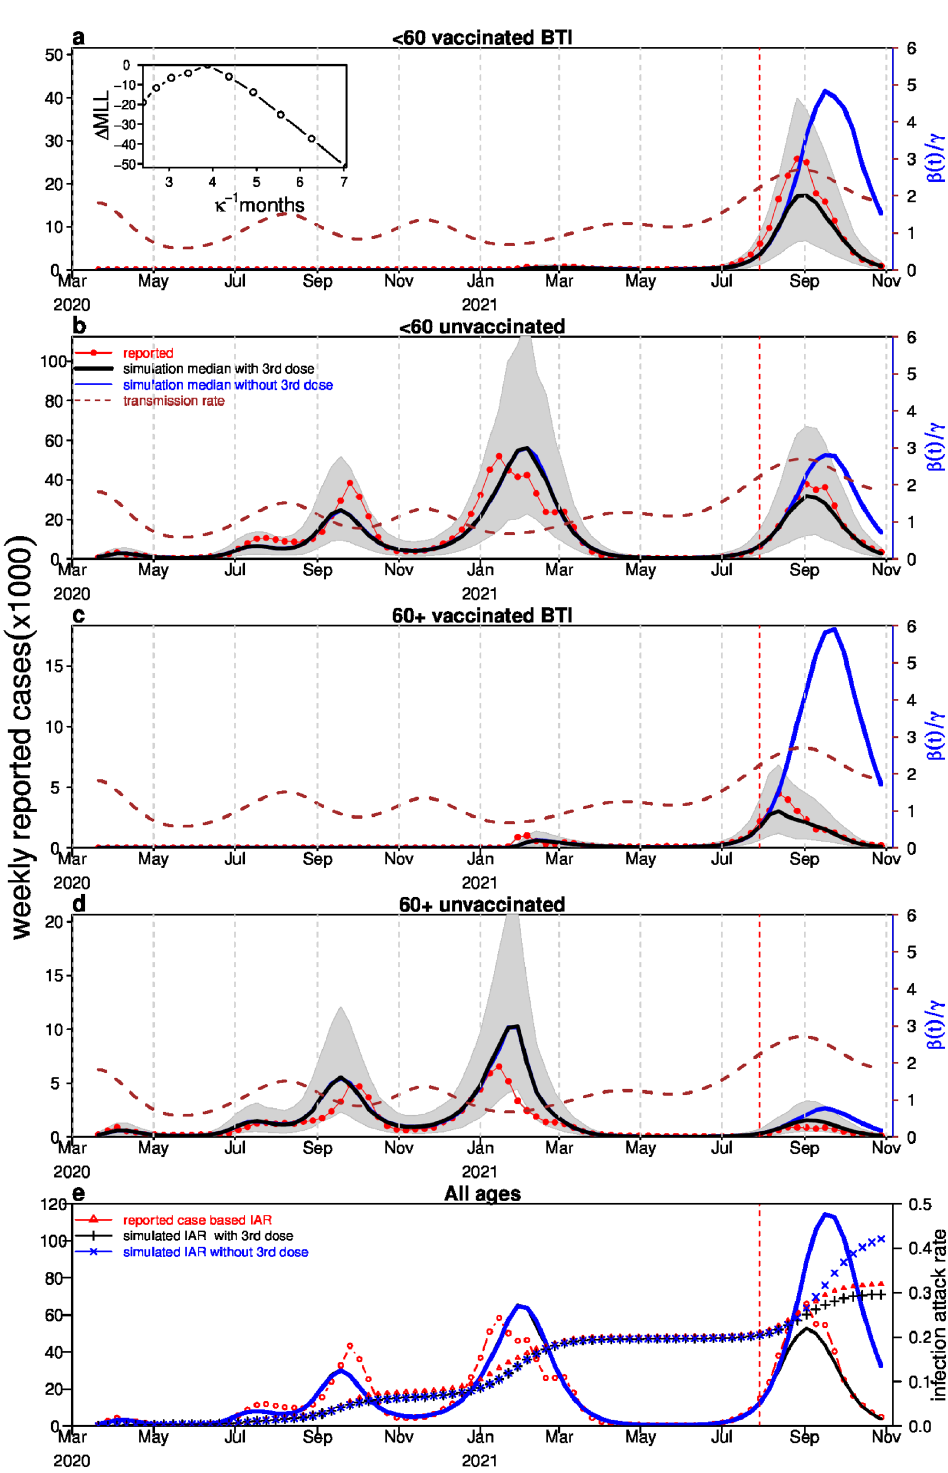
Fig 4. Model fitting results. The simulated cases (black bold) versus observed cases (red circles) for the < 60 age vaccinated group in (a); for the < 60 unvaccinated group in (b); for the 60+ vaccinated group in (c); for the 60 + unvaccinated group in (d) and for all groups in (e). The cases in (a,c) are BTIs. The brown dashed curve shows the time-varying basic reproductive number (i.e., a scaled transmission rate). The inset in panel (a) shows the profile maximum log-likelihood as a function of κ , and used to determine the best estimate of κ . The blue curves show